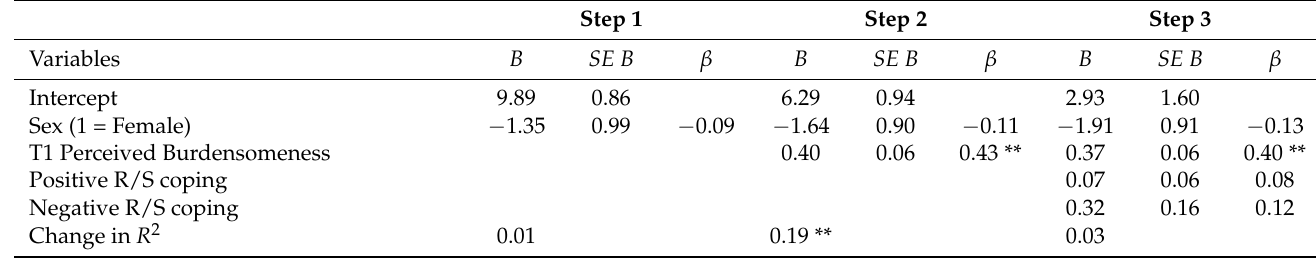
Table 2. Summary of hierarchical regression analysis for T2 Perceived Burdensomeness.